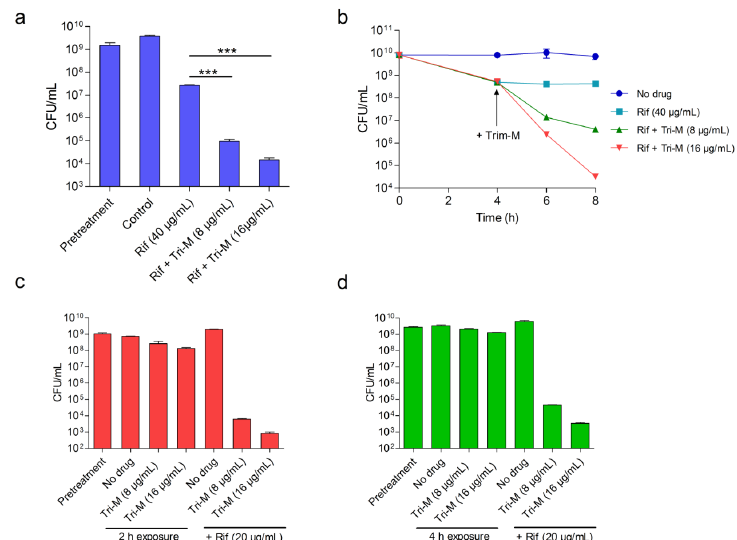
Figure 5. Time-lag kinetics of tridecaptin M and rifampicin combination to study the effect on bacterial killing. ( a ) The late-exponential phase bacteria were exposed with rifampicin or tridecaptin M alone and in combination. In the combination panel, both antibiotics were added at the same time. The significance was calculated using the paired Student’s t -test with two-tailed distribution, *** denotes p < 0.0001. ( b ) The bacteria were initially incubated with rifampicin, and then tridecaptin M was added. ( c ), ( d ) The bacteria were pre-treated with tridecaptin M for 2 h ( c ) or 4 h ( d ), and then